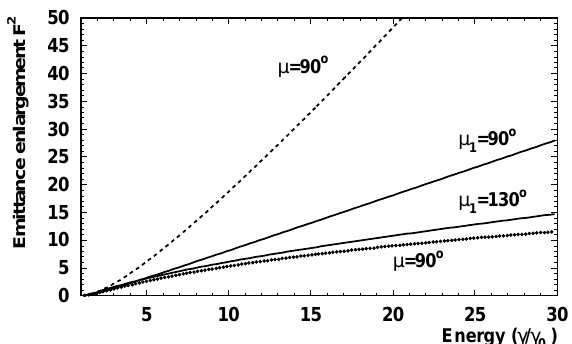
FIG. 2. The relative emittance enlargement factor F (cid:50) for different types of the lattice scaling along the linac. Shown are constant beta (dotted line), beta scaled as the square root of energy (dashed line) for a phase advance per cell m (cid:173) (cid:57)(cid:48) – , and the chromaticity scaled as the square root of g (cid:48) (cid:121) g for a phase advance per first cell m (cid:173) (cid:57)(cid:48) – and m (cid:173) (cid:49)(cid:51)(cid:48) – (solid